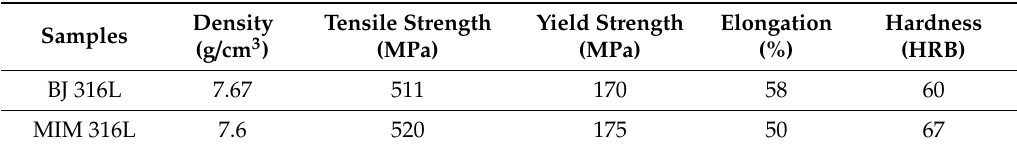
Figure 18. Optical micrographs showing pores structure for ( a ) sintered and ( b ) sintered and HIPed SS 316L [27] . Table 12. Mechanical performance of 316L for BJ printed and metal injection molding (MIM) samples [27] .